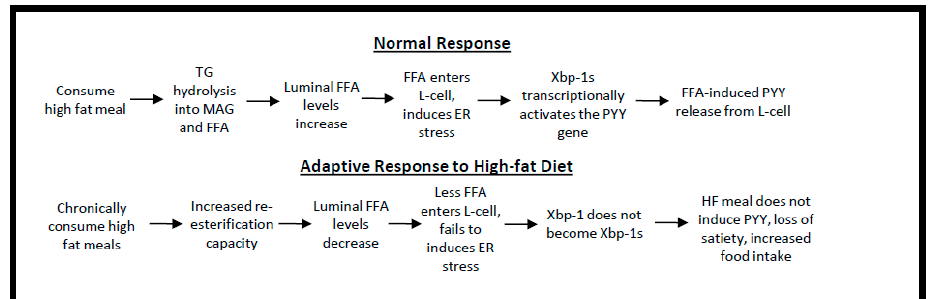
Figure 8. Conceptual Model. Dietary fat is ingested as triglyceride (TG) and digested into free fatty acids (FFA). The FFA’s in the intestinal lumen are potent inducers of satiety. However, the role of intestinal lipid synthesis is to re-esterify dietary FFA back into TG. The faster this happens, the less time FFA’s are available to induce satiety hormone production. A second aspect of the conceptual model is that FFA’s, especially saturated fatty acids (SFA), can cause a cell-stress like response by inducing X-box-binding protein 1 activation (Xbp1s). Xbp1s is a lipid sensitive transcription factor and the data suggest that it induces satiety hormone production. The faster rate of SFA desaturation to MUFA has two e ff ects: (1) less SFA will reduce Xbp1s-mediated PYY production and (2) more MUFA will speed TG synthesis which will reduce FFA-mediated satiety leading to greater food intake and